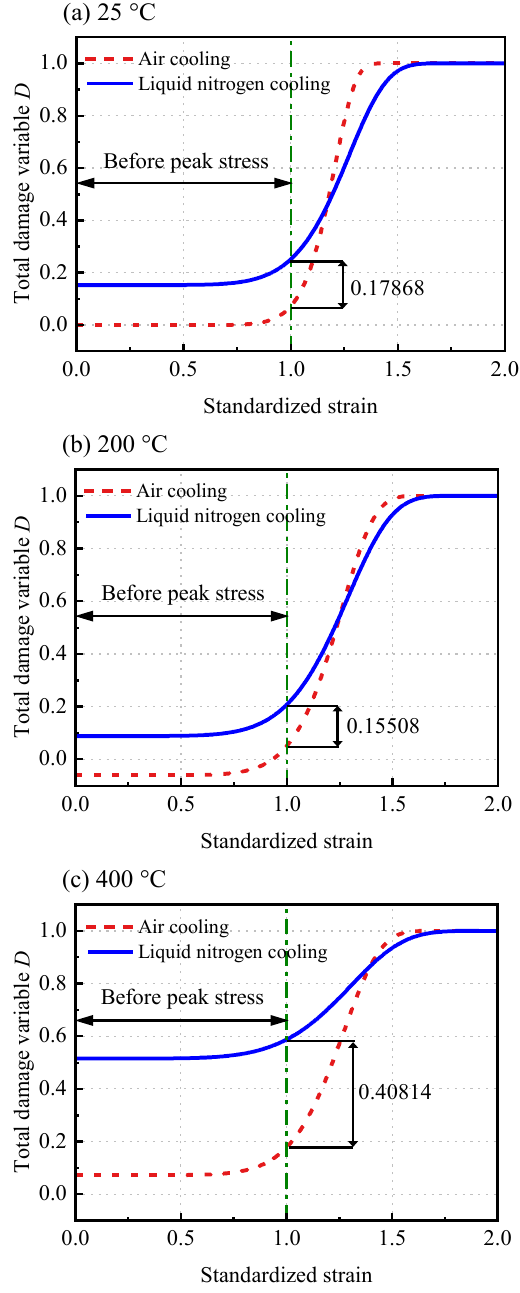
Figure 9. Total damage variables versus standardized strain.